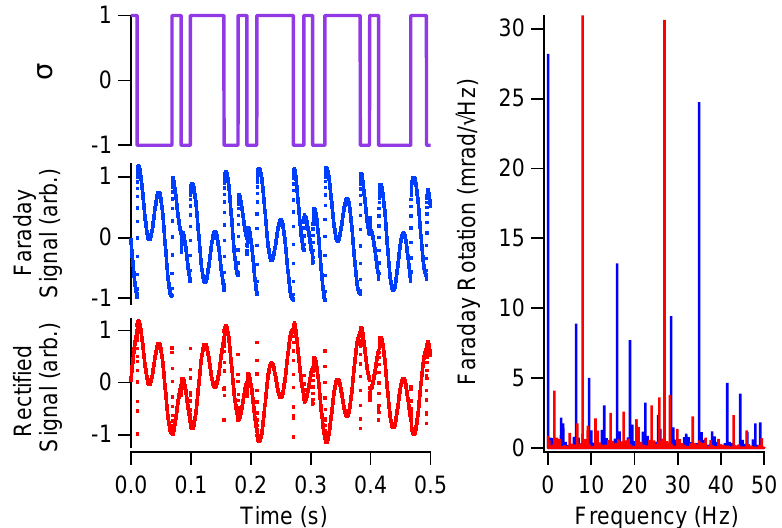
Figure 3. Measured square wave PM signals. Top: S + ( t ) . Middle: S z ( t ) . Bottom: Rectified S z ( t ) . The plot on the right shows the amplitude spectral density with (red) and without (blue) rectification.